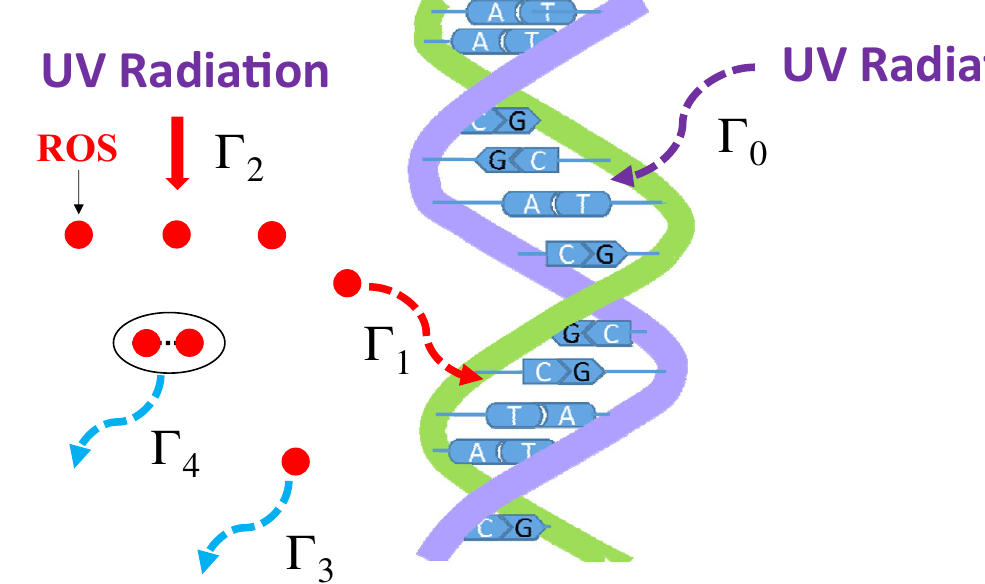
Figure 3. Quantitative model describing DNA damage processes. UV radiation directly causes DNA damage by the formation of thymine dimers or the generation of ROS radicals (red circles) at bacteria by UV radiation, which damages DNA. The rates of DNA damage are described as follows: Γ 0 (cm 2 /mJ): UV radiation directly causes DNA damage by the formation of thymine dimers, Γ 1 (cm 3 /s): ROS radicals damage DNA, Γ 2 (cm 2 /mJ): ROS radicals are generated at the bacteria by UV radiation, Γ 3 (s −1 ): lifetime of ROS radicals, and Γ 4 (cm 3 /s): mutual destruction of ROS radicals.